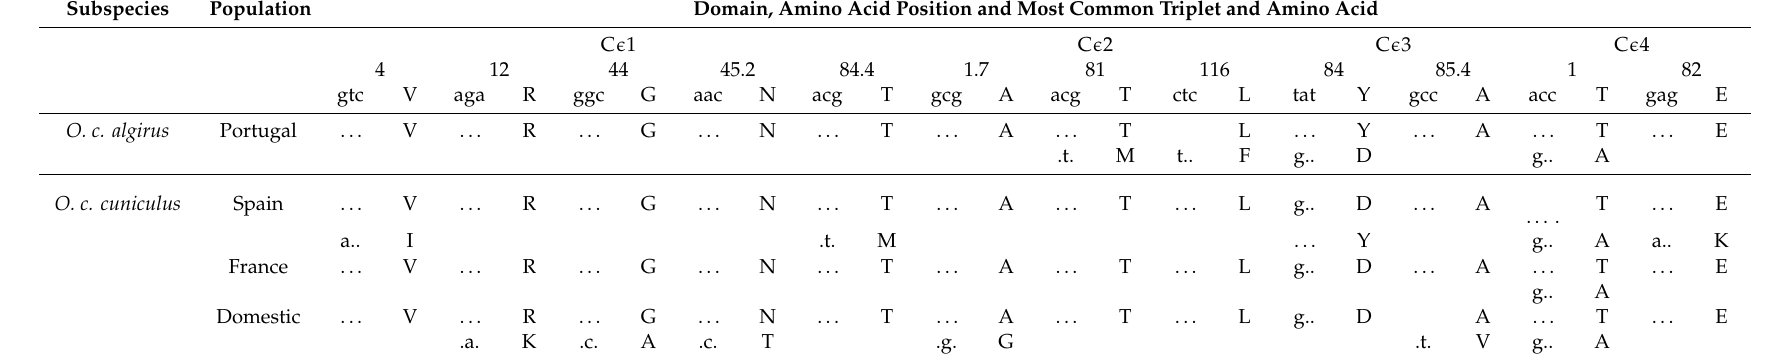
Table 3. IgE amino acid polymorphic positions for European rabbit populations / domestic animals. The nucleotide variation is shown, dots represent identity. The codon numbering is according to the IMGT unique numbering for the constant domain